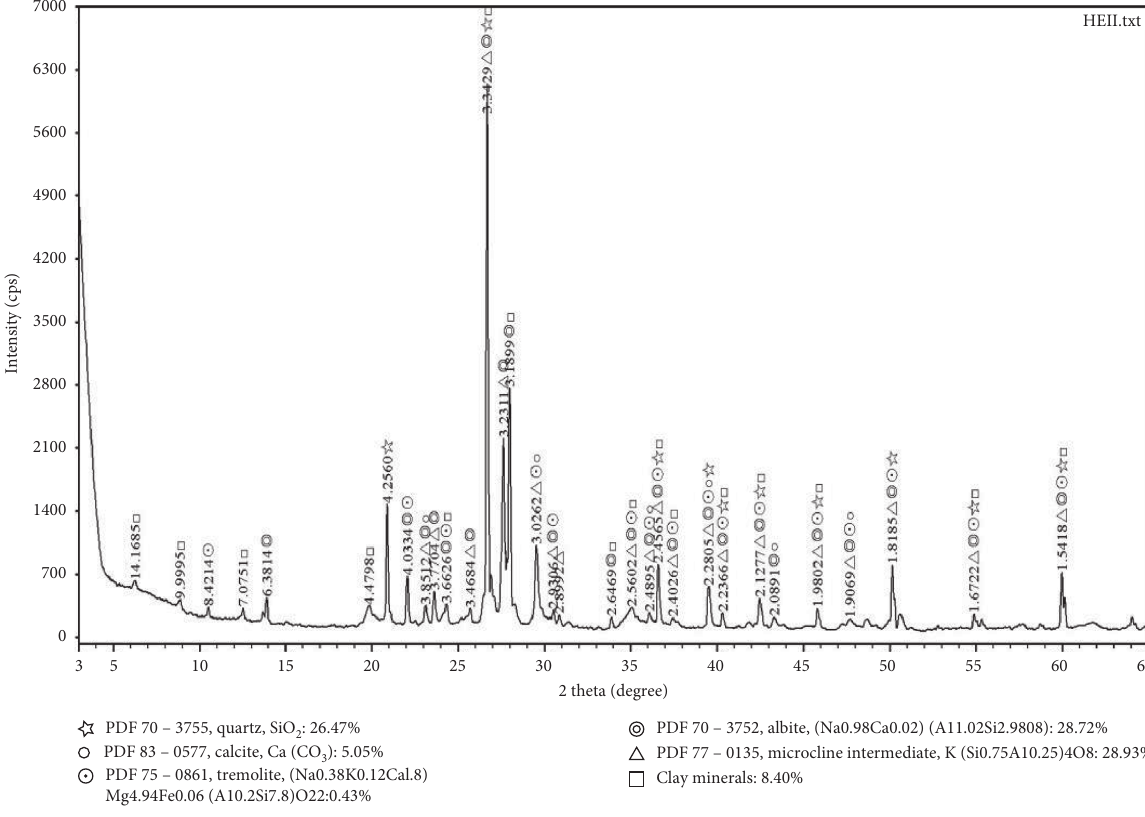
Figure 8: XRD analysis of dispersive soil sample. Table 7: Partial chemical composition content of dispersive soil.